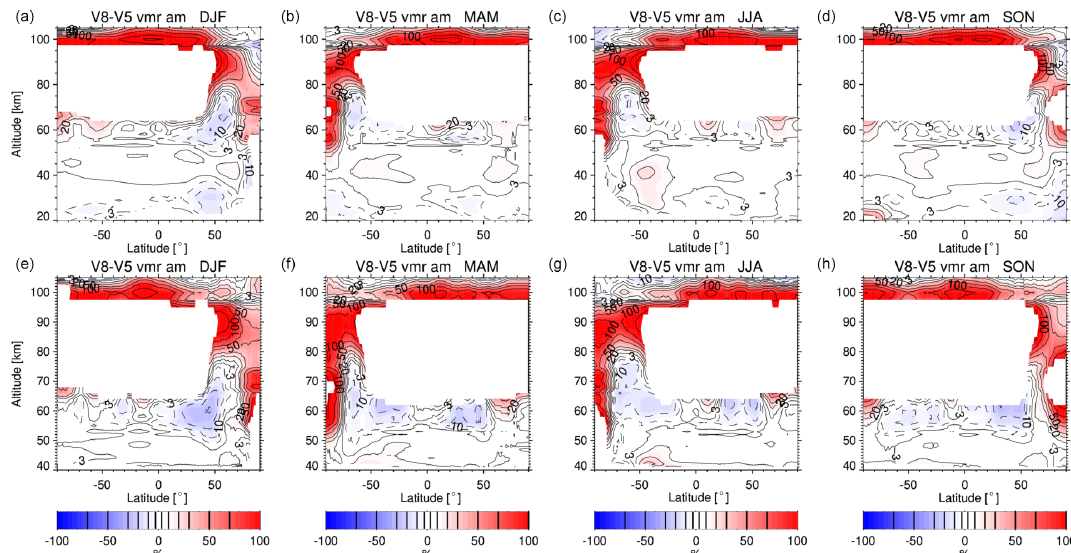
Figure 12. Seasonal composite zonal mean distributions of the relative NO vmr differences between morning observations of version 8 and version 5 as a function of latitude and altitude for (a–d) MA and (e–h) UA. Specifically, version 5 data used here are V5r_NO_521 (MA) and V5r_NO_622 (UA). Left to right: DJF, MAM, JJA, SON.